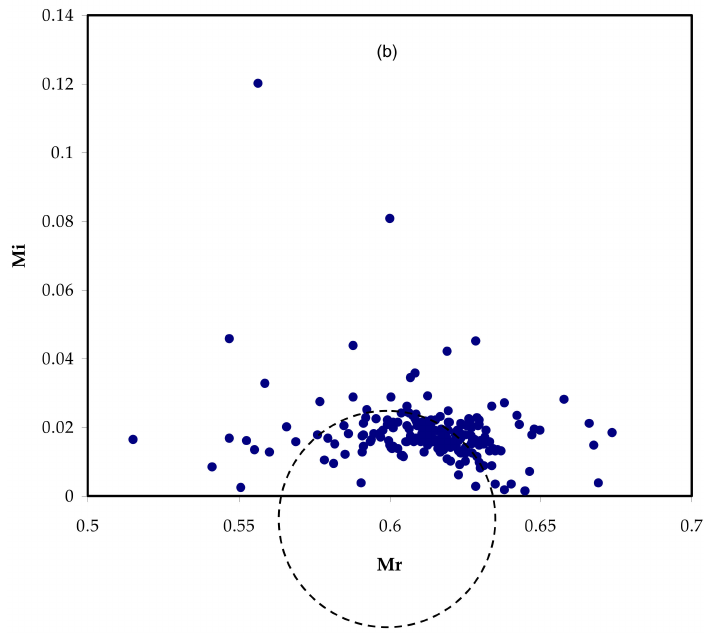
Figure 10. Argand plots ( a ) ε r versus ε i and ( b ) M r versus M i